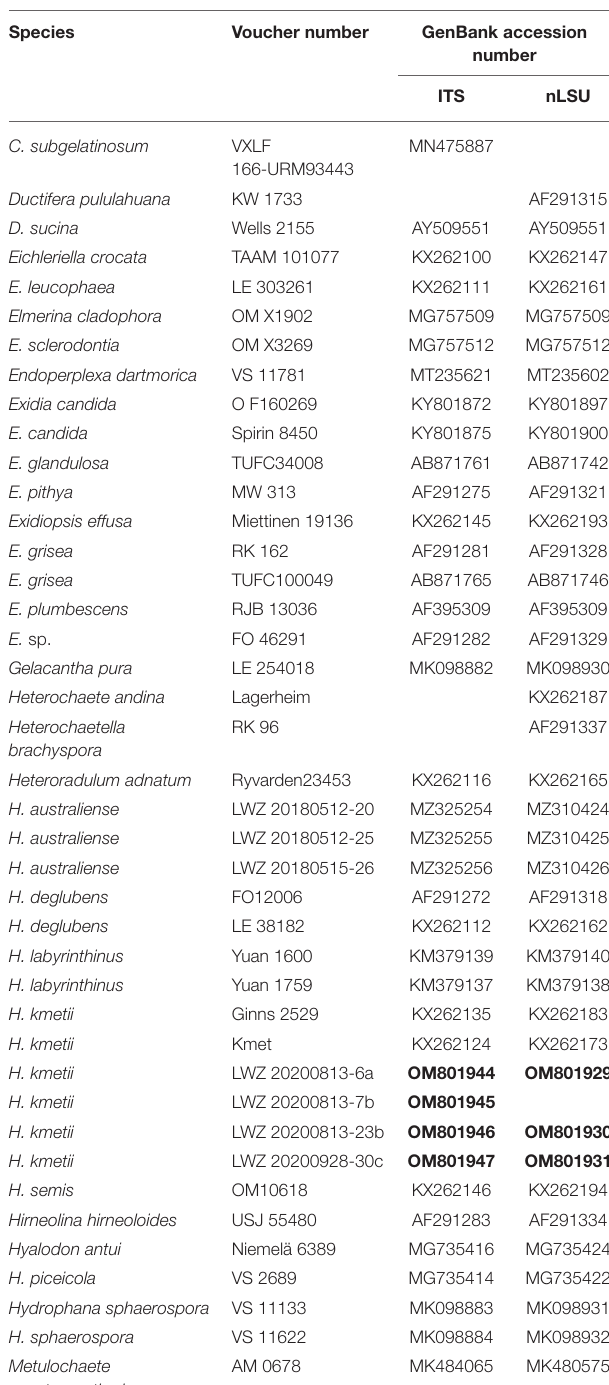
TABLE 1 | Species and sequences used in the phylogenetic